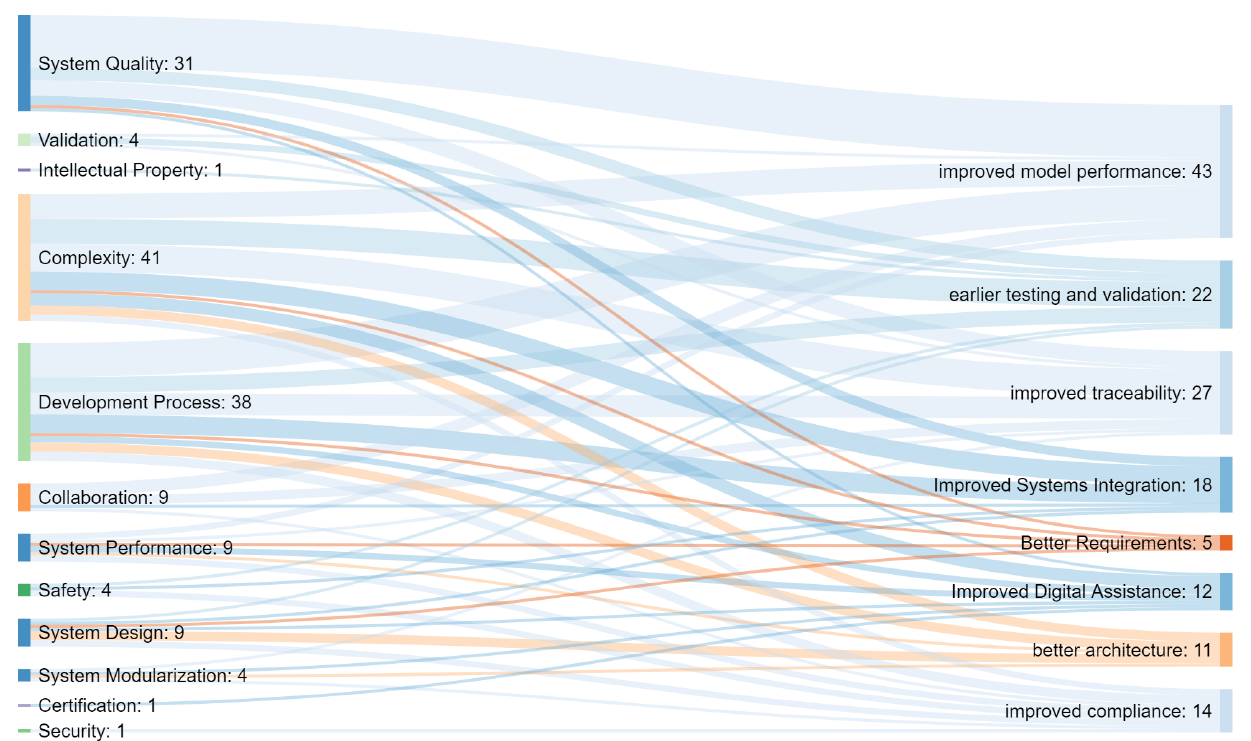
Figure 11. Sankey-flow chart with drivers depicted on the left side and indicators on the